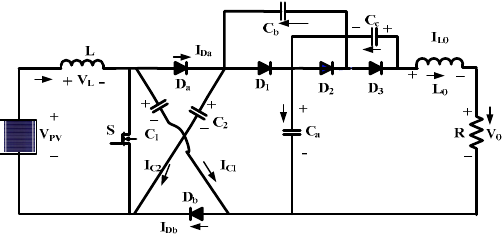
Figure 12. Switched capacitor boost converter [24].